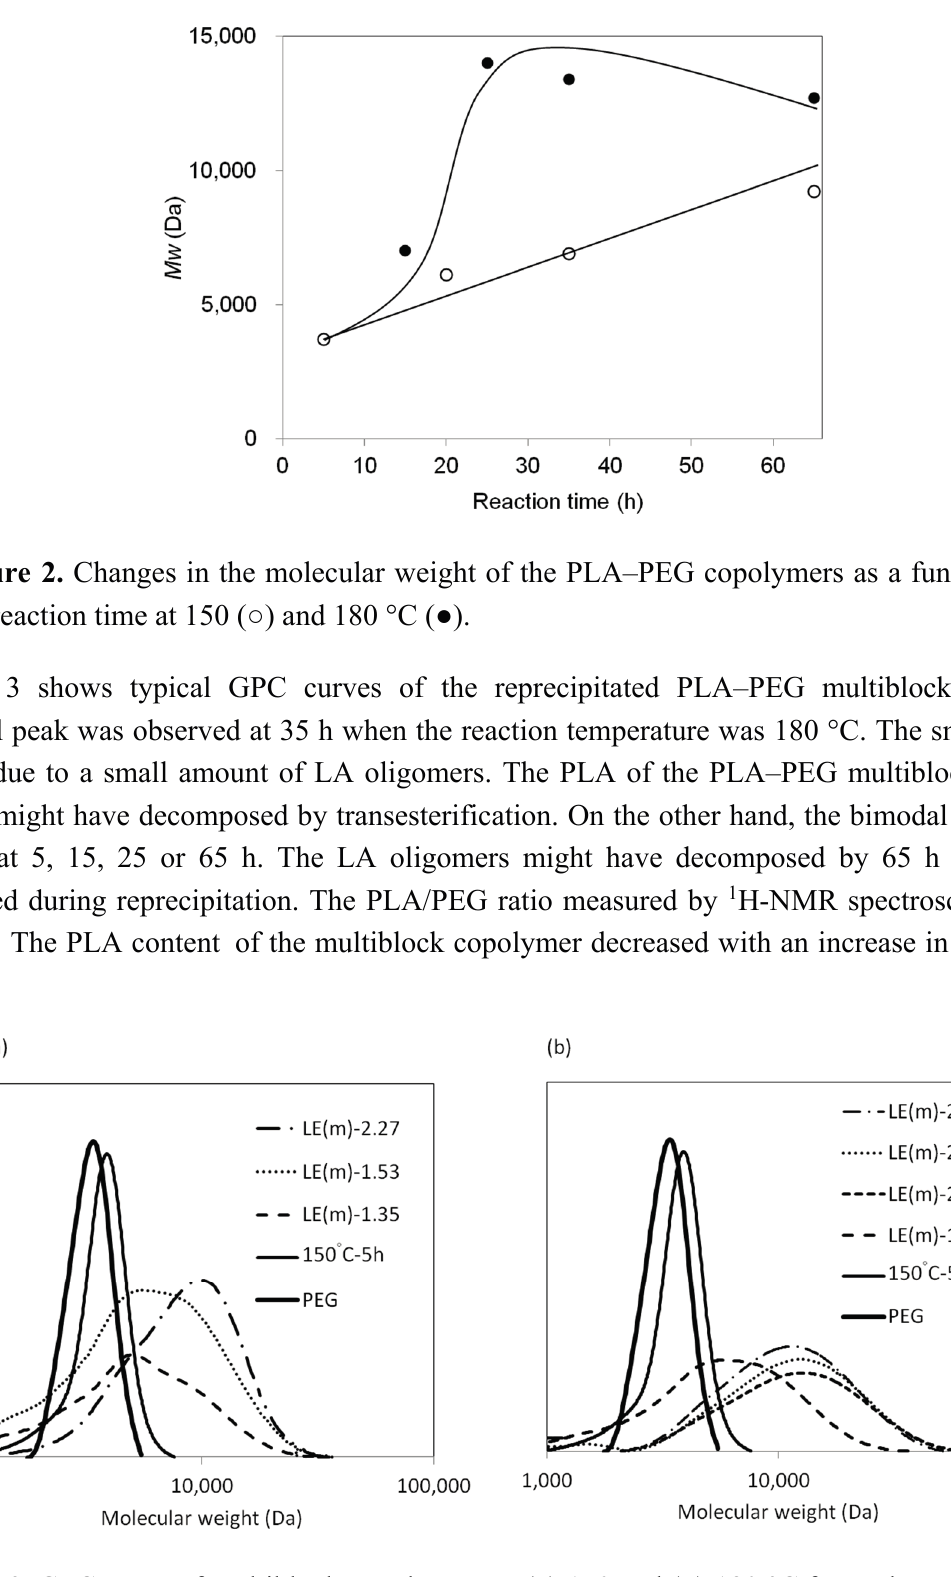
Figure 3. GPC curve of multiblock copolymers at ( a ) 150 and ( b ) 180 °C for each reaction